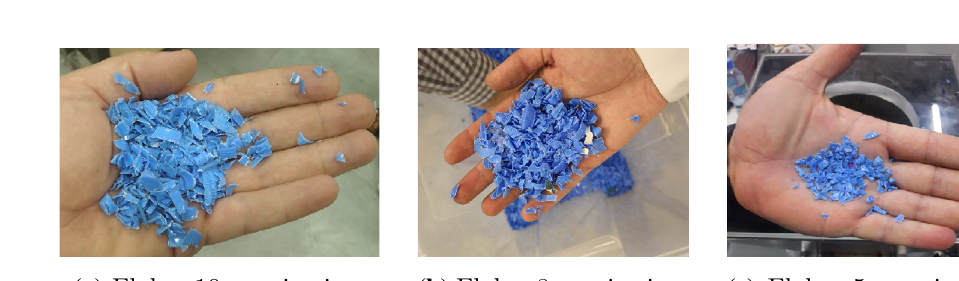
(b) Perforation hole size of 8 mm